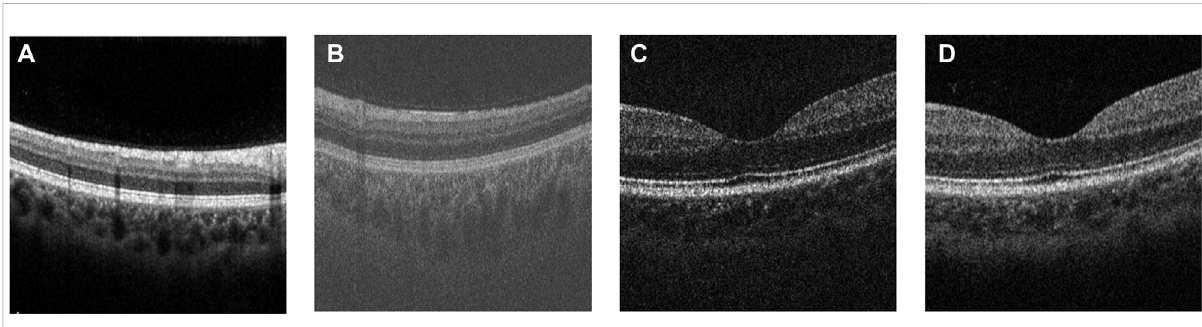
FIGURE 5 Examples of the original OCT images from (A) COSTA-H dataset, (B) COSTA-T dataset, (C) COSTA-B dataset (6 bit-depth), and (D) COSTA-B dataset (12